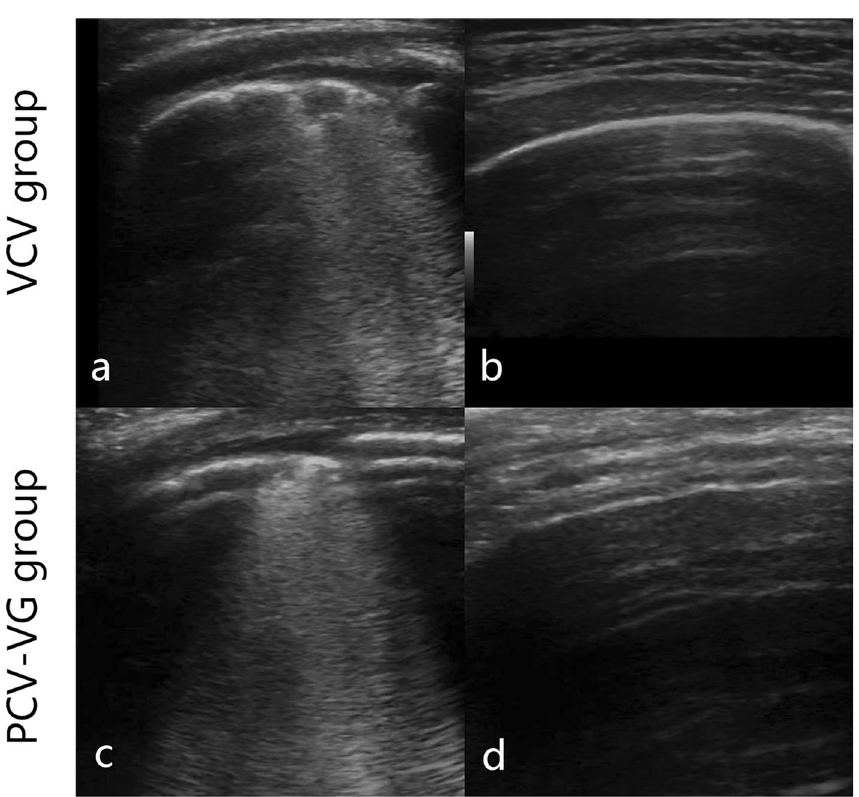
Figure 4. Lung ultrasound findings of dependent lung in the PCV-VG and VCV groups. The images were obtained from the posterior region of the dependent lung. ( a ) Lung aeration after surgery in VCV group. ( c ) Lung aeration after surgery in PCV-VG group. ( b ) Lung aeration 2.5 h after surgery in VCV group. ( d ) Lung aeration 2.5 h after surgery in PCV-VG group. VCV volume controlled ventilation, PCV-VG pressure controlled volume guaranteed